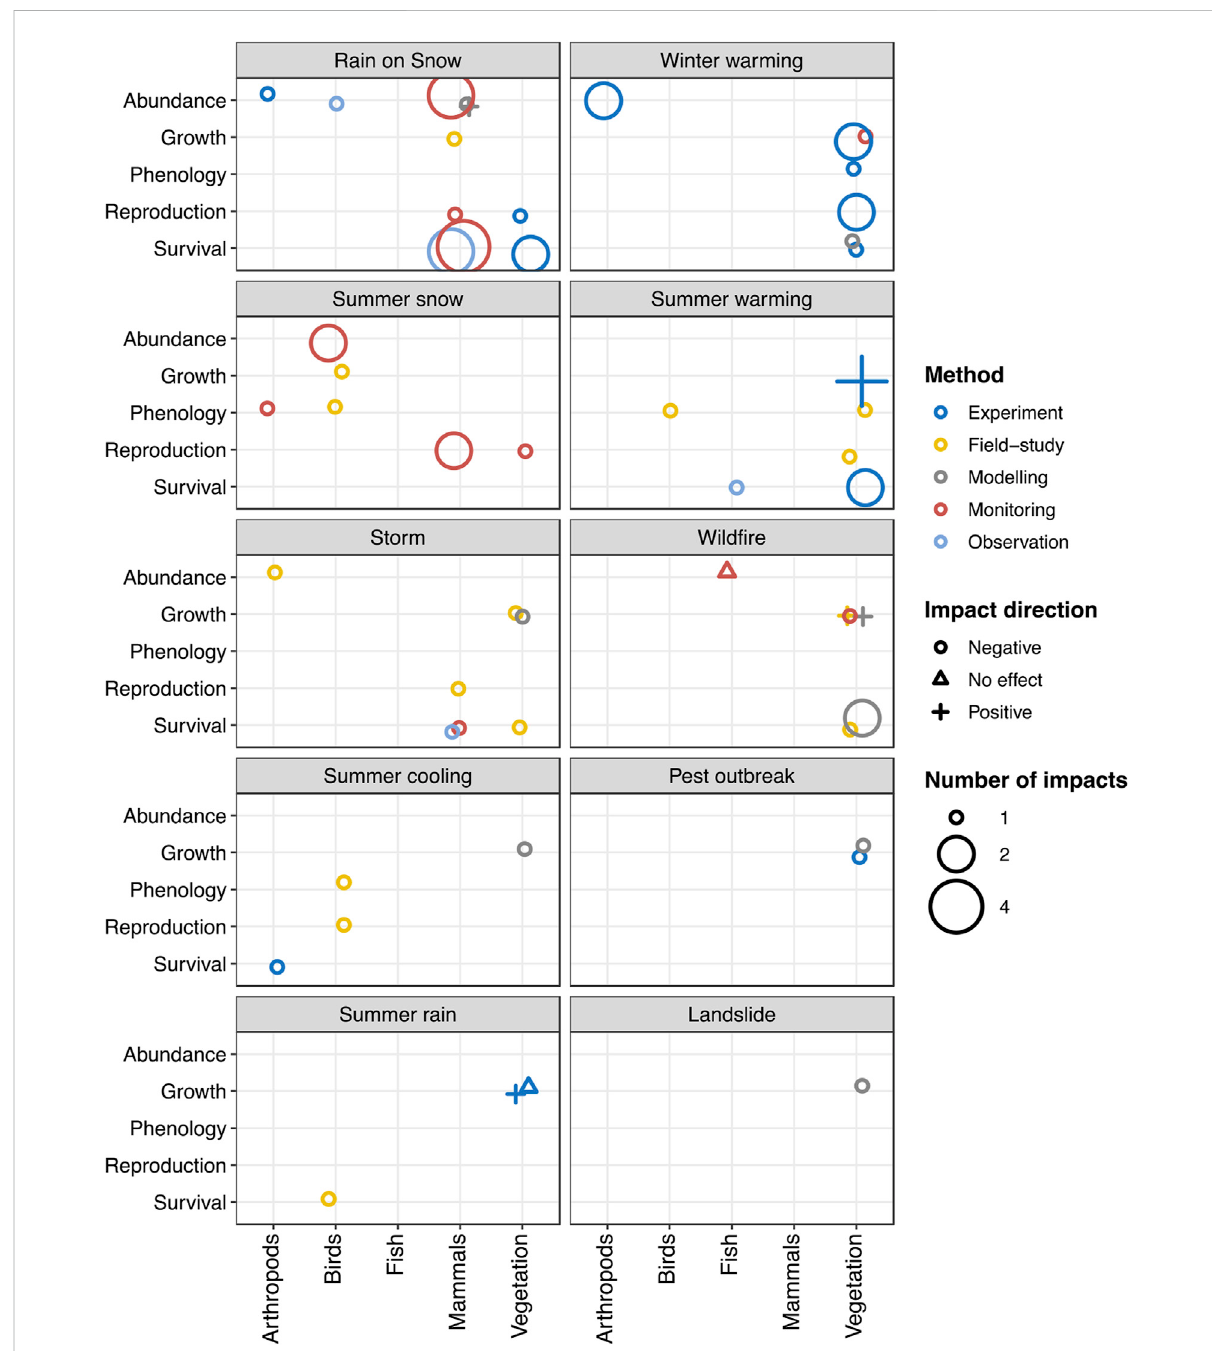
FIGURE 2 Categorizationoftheecological impacts (n=69)ofextremeevents onbiotathatwereobserved interrestrialand freshwaterArcticecosystems asdocumented in48studies published between 1995and2021. Theshapesofthesymbolsindicate thedirectionoftheecological impactdetected. The colours of the symbols re fl ect the method used to quantify the impact, and the size of the symbols are scaled relative to the number of studies that detected the